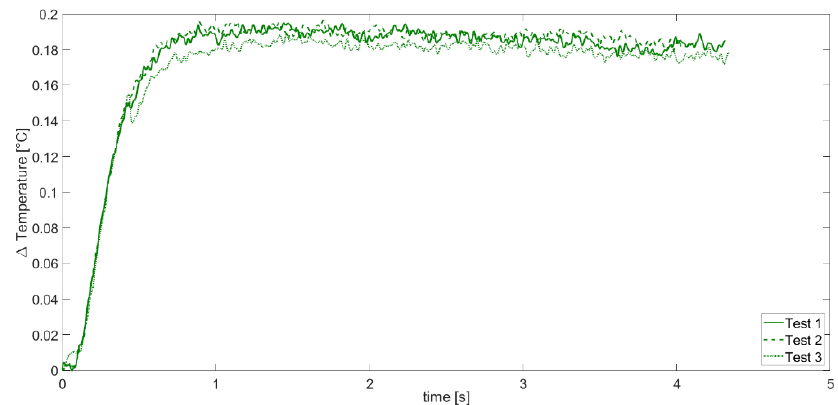
Figure 14. SPS: relative temperature ∆ Temperature .